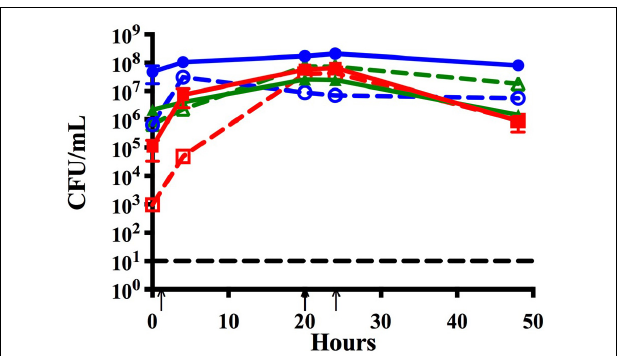
FIGURE 2 | Time course assay analyzing monomicrobial and triple species biofilms in vitro . Bacteria were grown in monomicrobial (dashed) or triple species biofilms (solid). Biofilms were seeded simultaneously and maintained with media changes (black arrows) for 48 h. NTHi86-028 NP (blue), M. catarrhalis 7169 (green), and S. pneumoniae EF3030 (red) monomicrobial and triple species biofilms. Black dashed line indicates the limit of CFU detection. Each symbol and error bar represent the mean CFU per mL and standard deviation (SD) of biofilms at the respective time point. Data presented are from three independent assays with a minimum of two biologic replicates per